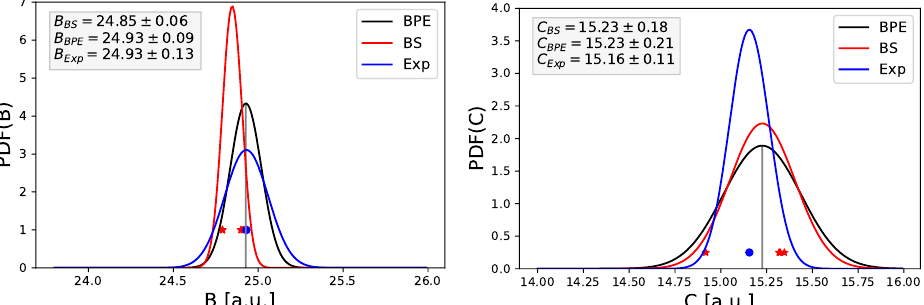
Figure 3. ( Left side ): Individual model predictions of B for a value of A = 50.0 from the bootstrapped GP models (red stars) in combination with the mean value from the observed values (blue circle). The blue curve shows the observed experimental distribution, the red curve the simplified estimate from the boostrapped GP model predictions, and the black curve the corresponding distribution of B from the Bayesian predictive ensemble calculations. ( Right side ): Individual model predictions of C for values of B = 24.87 and τ = 0.5 from the bootstrapped GP models (red stars) in combination with the mean value from the observed values (blue circle). The blue curve shows the observed experimental distribution, the red curve the simplified estimate from the boostrapped GP model predictions, and the black curve the corresponding distribution of C from the Bayesian predictive ensemble calculations. All units are